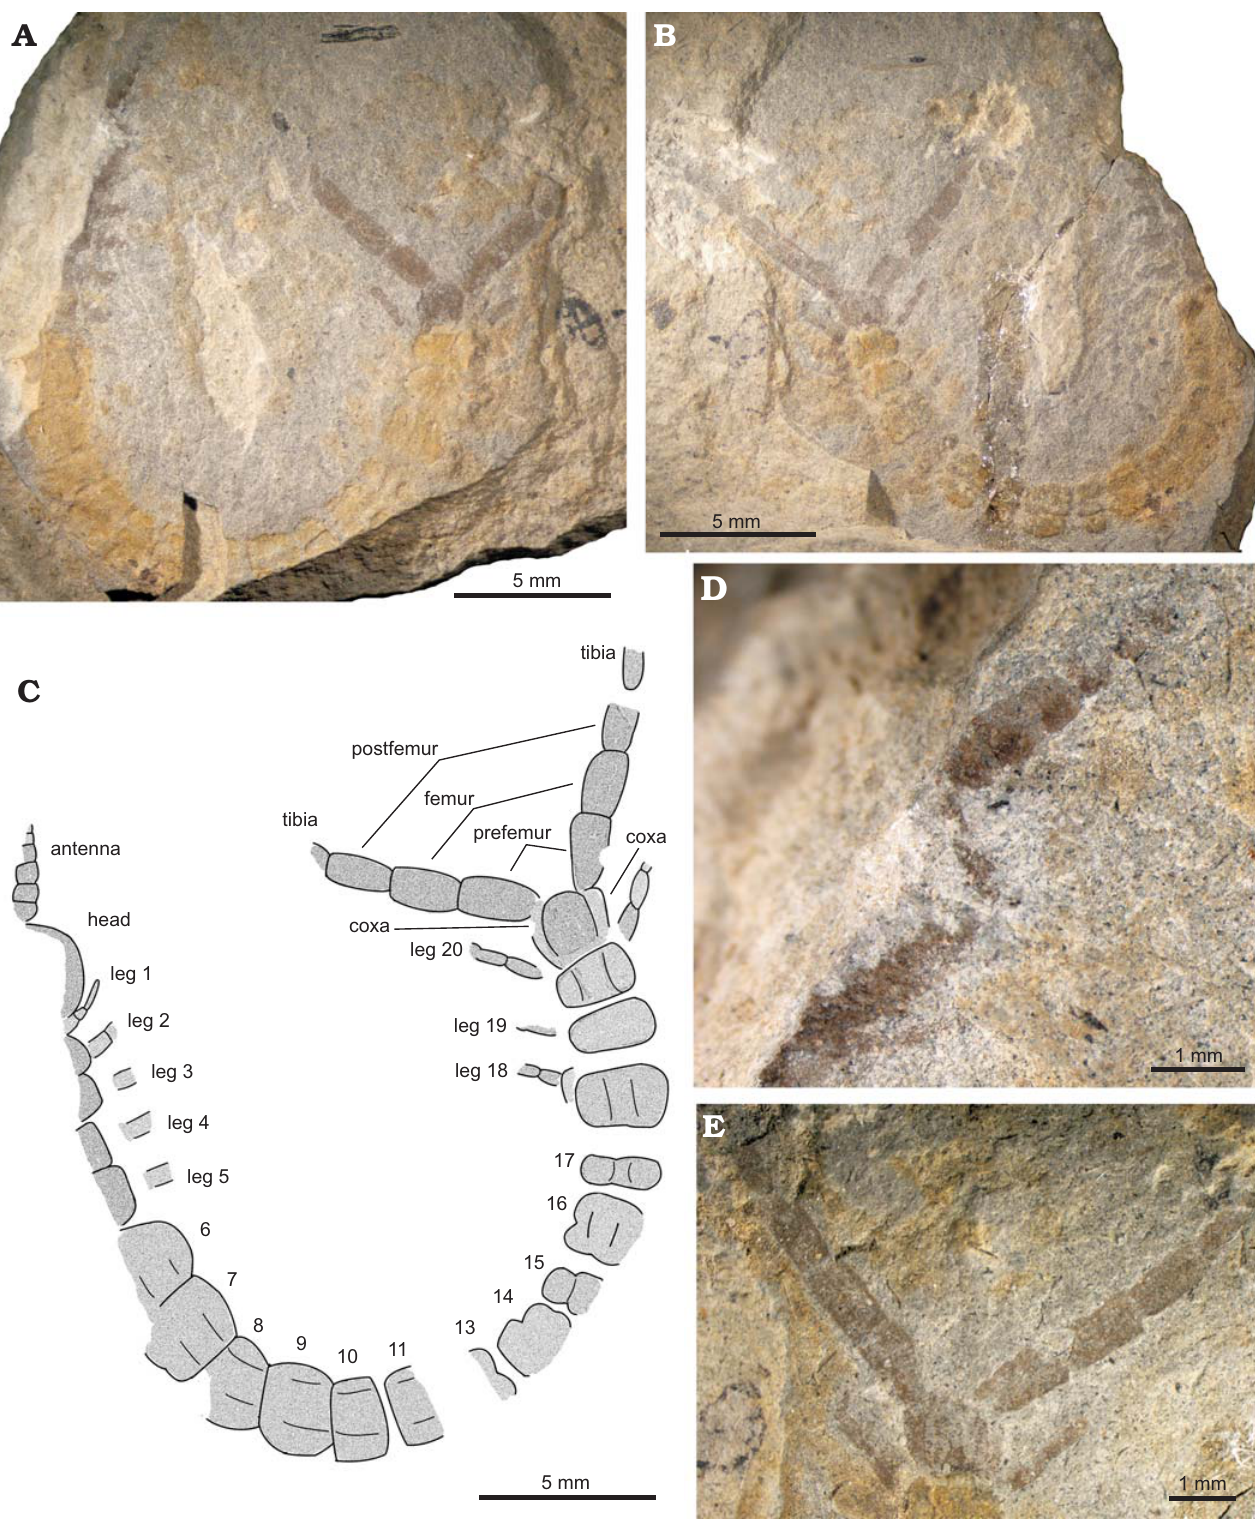
Fig. 1. Scolopendromorph chilopod Permocrassacus novokshonovi gen. et sp. nov., holotype VSGM 1/viii/46 60 a, b, Tshekarda locality, lower Permian of Russia. A , B . General view of part and counterpart, respectively. C . Drawing compiled from part and counterpart. D . Head, antenna, and 1st leg. E . Pairs of 20th and ultimate legs. Numbers indicate segments of trunk or without spines or processes, preserved podomeres subequal Stratigraphic and geographic range .—Type locality and in length and thickness, about 3 times as long as thick. horizon only.